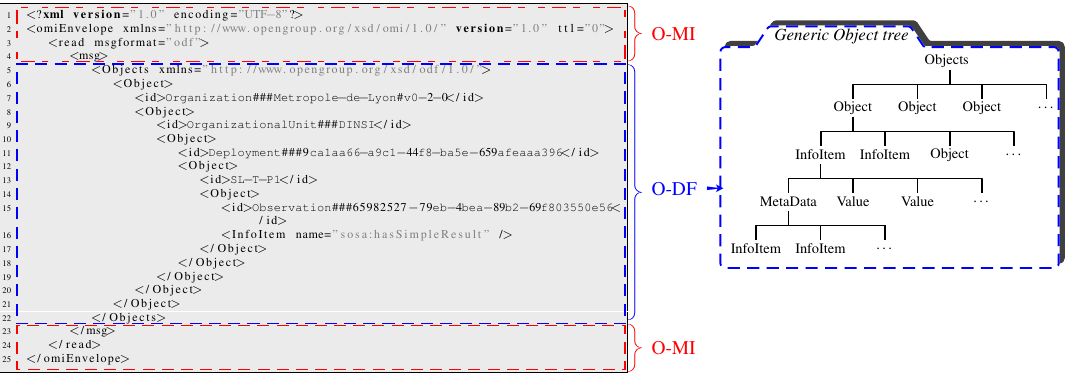
Figure 10. O-MI/O-DF: generic object tree and example of a O-MI/O-DF message relying on that tree.